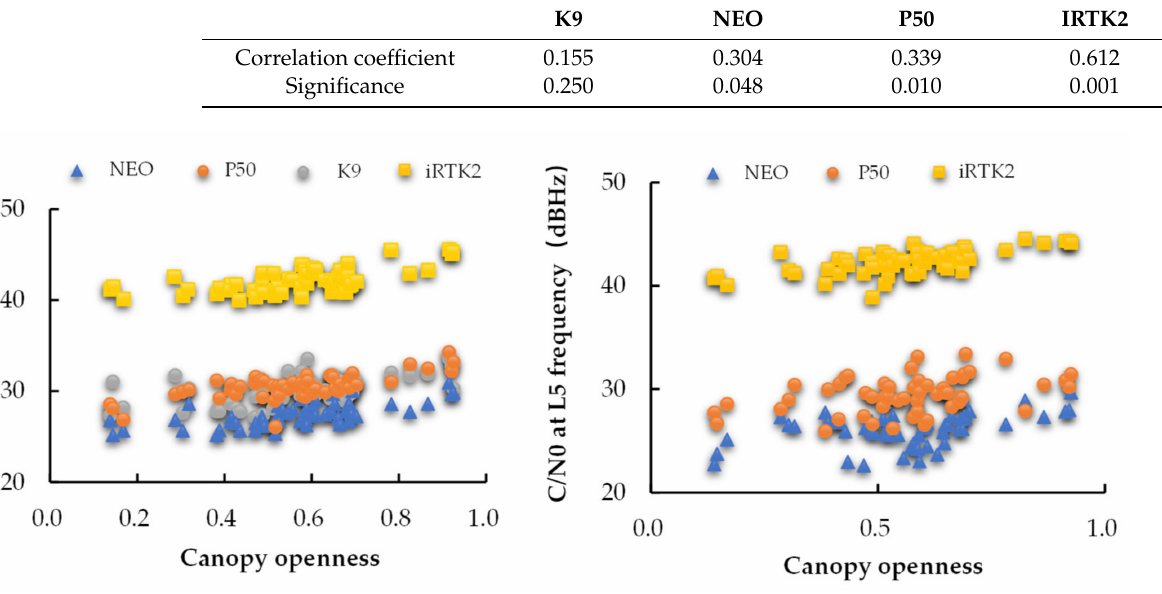
Figure 8. Carrier-to-noise density(C/N0) at L1 and L5